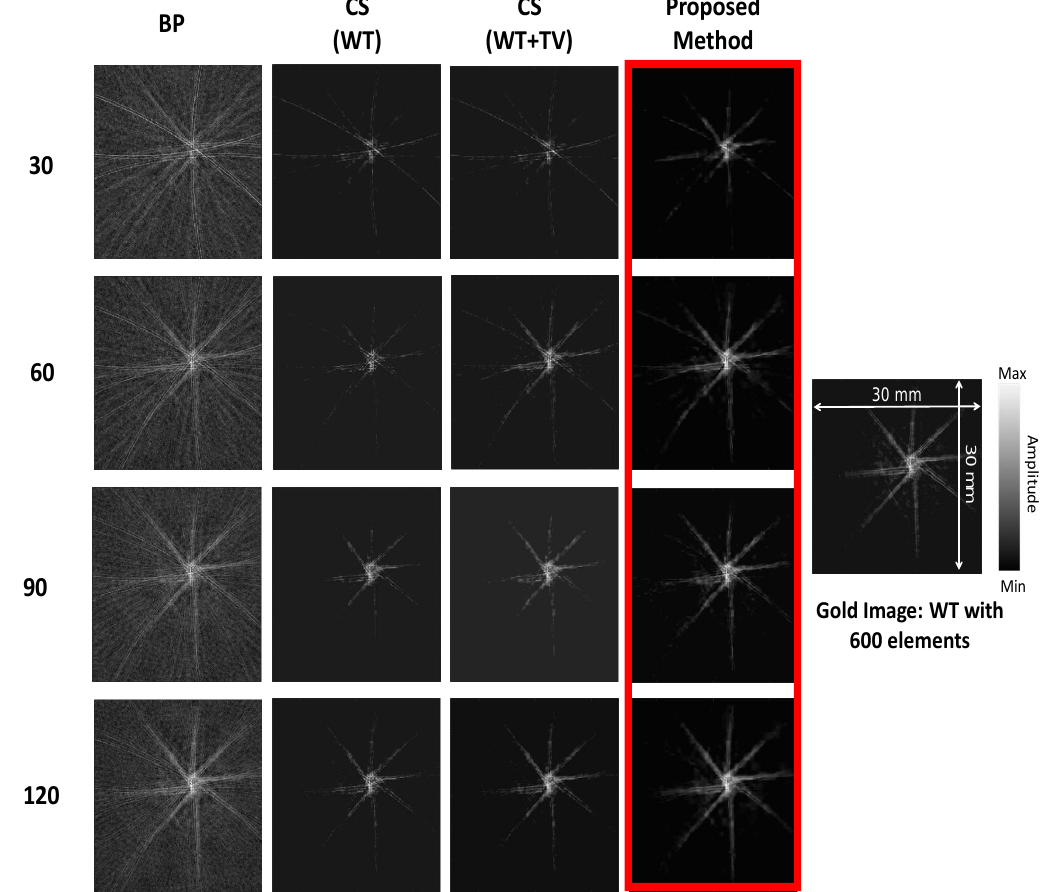
Figure 4. Results of reconstruction algorithms on the phantom data acquired from our PACT system. Different rows show different number of views, 30, 60, 90, and 120, and columns show different reconstruction methods, BP, sparse with basis WT, sparse with basis WT+TV, and sparse with the proposed sparsifying